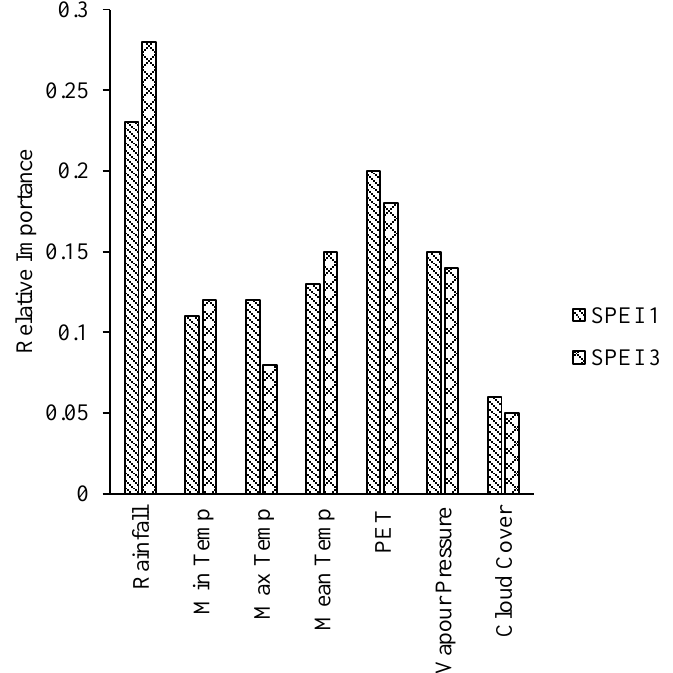
Figure 6. Relative importance of the variables for predicting SPEI 1 and SPEI 3 during training period.